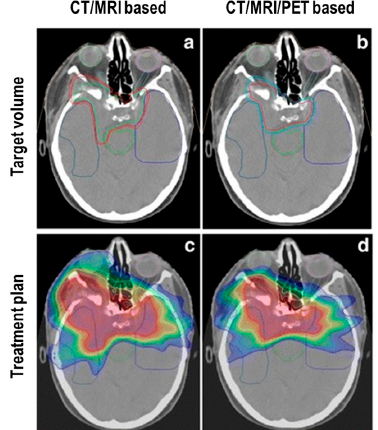
Figure 2. Reduction of IMRT target volume provided by adding 68Ga-DOTATOC-PET to CT and MRI. Panel ( a ) and ( b ) display the target volume based on CT and MRI and CT, MRI as well as 68Ga-DOTATOC-PET, respectively in a patient treated for a skull base meningioma. Panel ( c ) and ( d ) show the corresponding IMRT treatment plans. The present case shows the reduction of dose to OAR by adding SSTR-PET imaging to treatment planning. Adapted with permission from Stade et al.